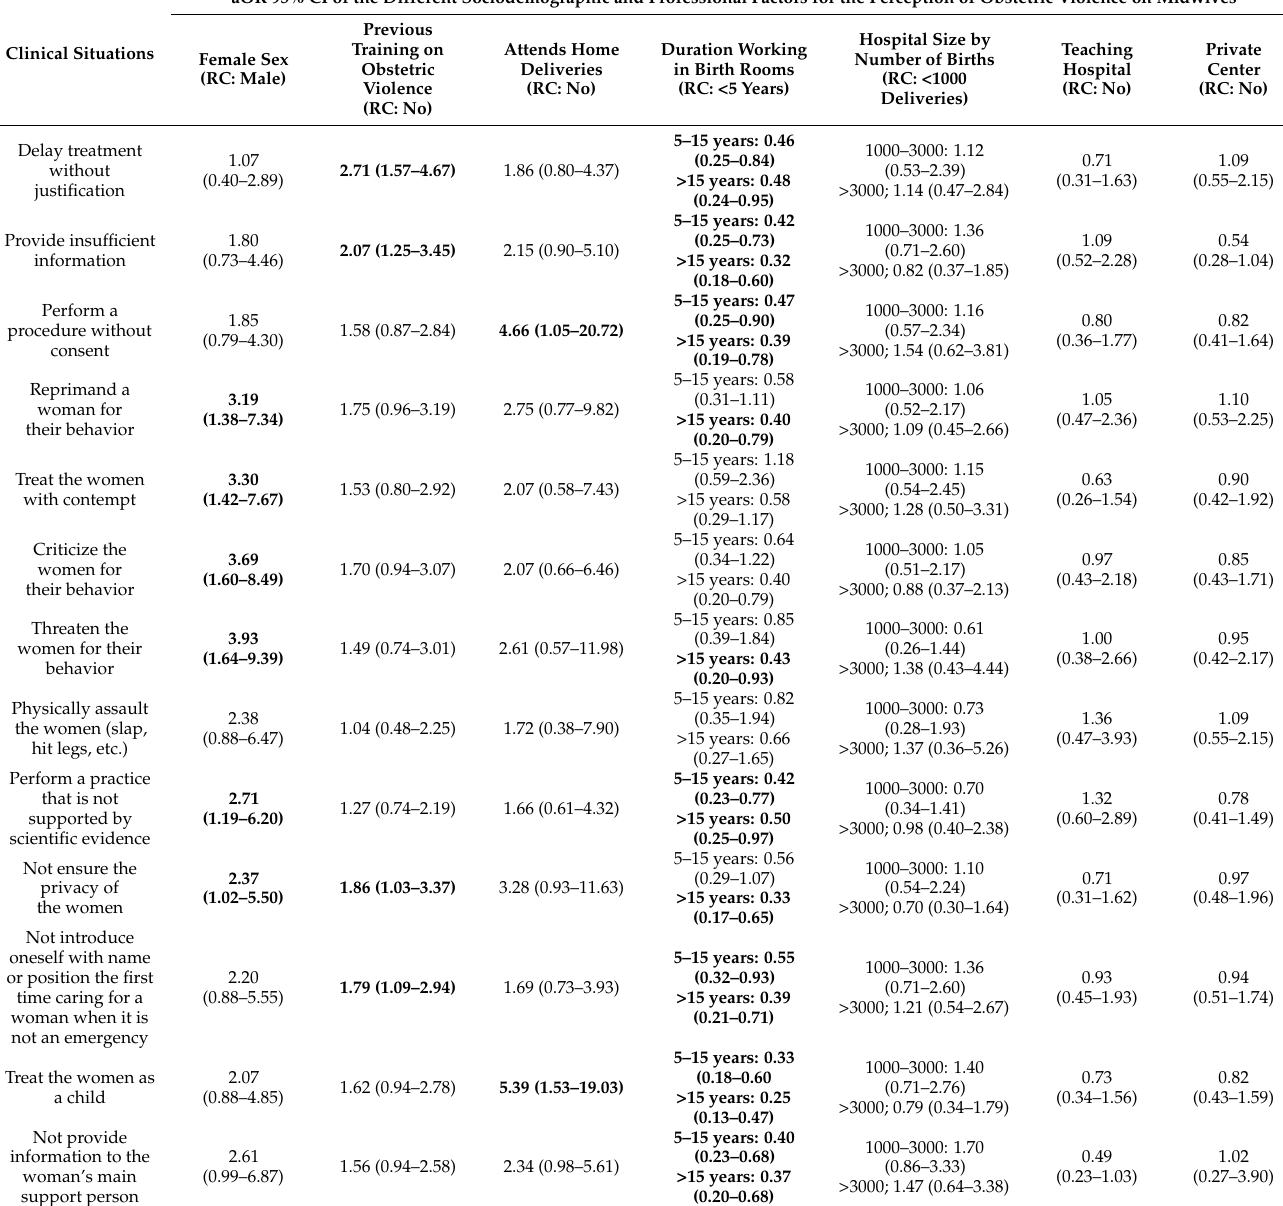
Table 4. Factors related to the perception of obstetric violence among